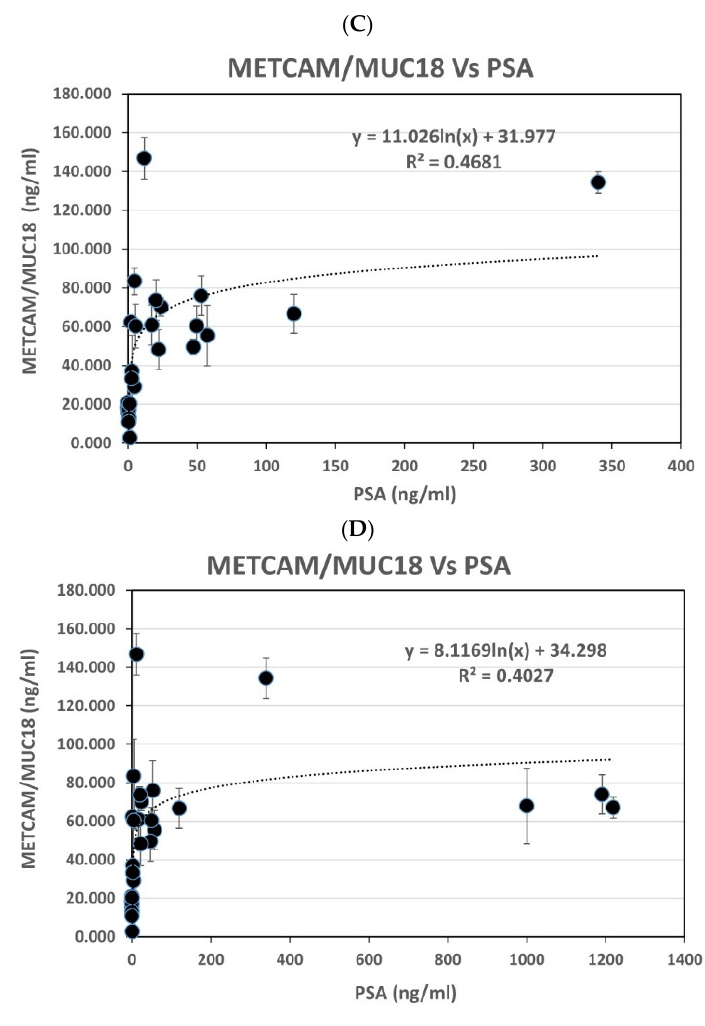
Figure 4. ( A ) METCAM vs. PSA (#1) combo1, ( B ). METCAM vs. PSA (#2) combo1, ( C ) METCAM vs. PSA (#3) combo1, ( D ) METCAM vs. PSA (#4) combo1. Relation of PSA to the